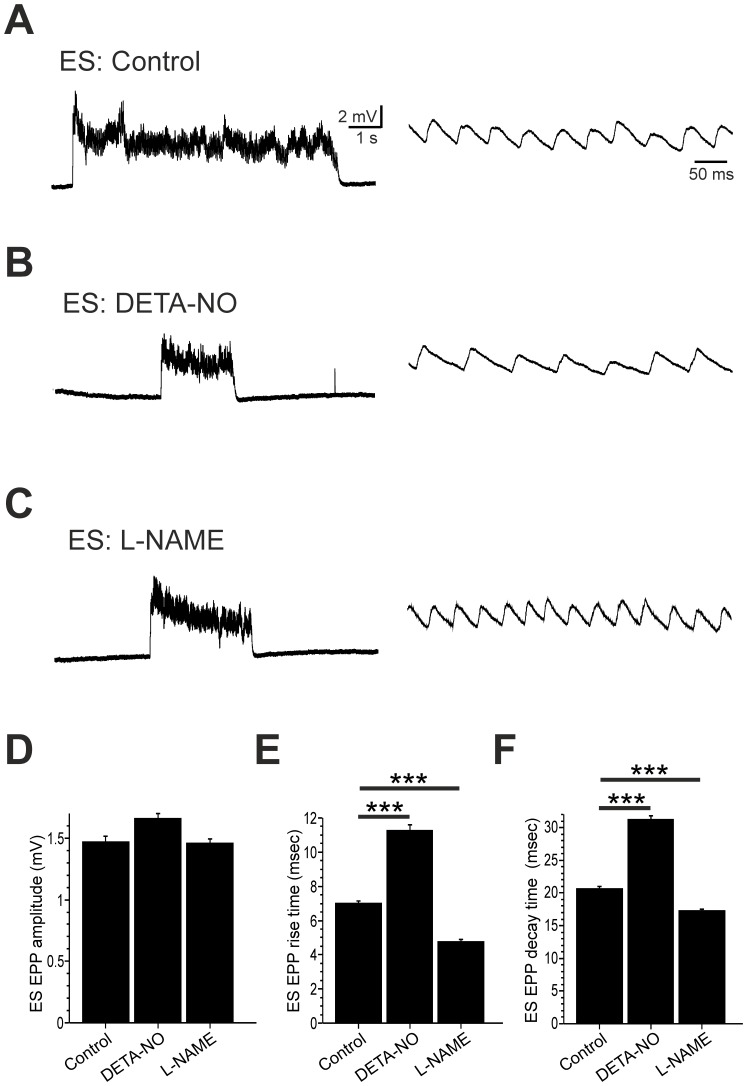
Developmental NO manipulation perturbs fictive locomotor drive to ES muscle fibres.
A–C. Voltage recordings of locomotor-related drive obtained from embryonic slow (ES) fibres of control (A), DETA-NO raised (B) and L-NAME raised (C) fish at 2 days post fertilisation (dpf). D–F. Mean end plate potential (EPP) amplitude (D), rise time (E) and decay time (F) measured during episodes of fictive swimming. Data in D-F are represented as mean ± SEM. *** p<0.001.